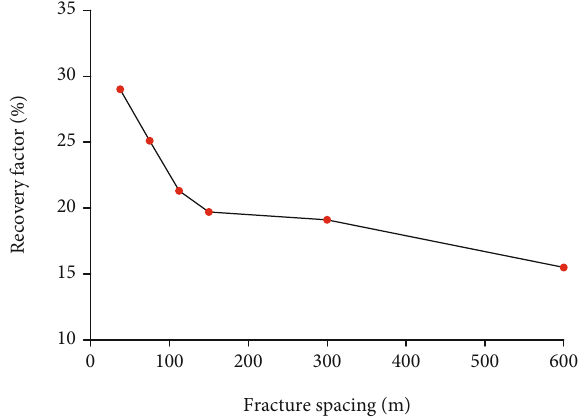
Figure 10: Ultimate recovery factors of reservoirs with di ff erent Sor reduction values by cyclic surfactant injection.